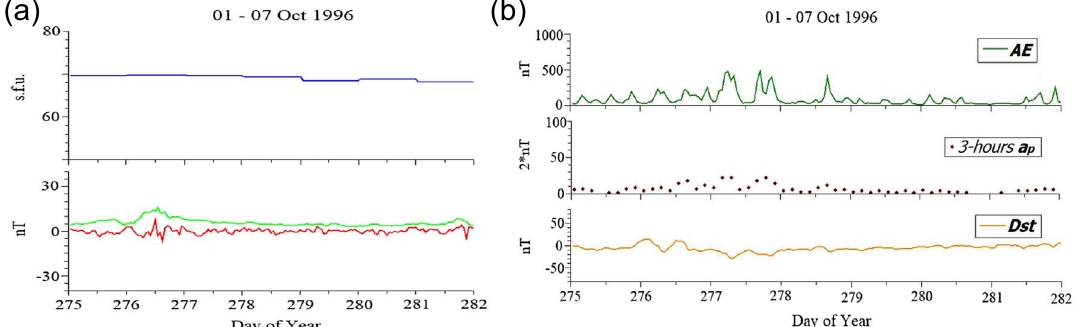
Fig. 10. In panel (a) is described, from up to down, Solar fl ux F10.7 from 01 to 07 October 1996 and, for the same time period, the behaviour of the magnitude and the Z component of the IMF. Panel (b) shows, from up to down, the AE , the a p and the Dst indices, from 01 to 07 October 1996. (The hourly AE index data are retrieved through the Kyoto AE index service http://wdc.kugi.kyoto-u.ac.jp/dstae/index.html. Three-hour a p data are provided by NOAA ftp://ftp.ngdc.noaa.gov/STP/GEOMAGNETIC_DATA/INDICES/KP_AP. Dst and Solar data are obtained